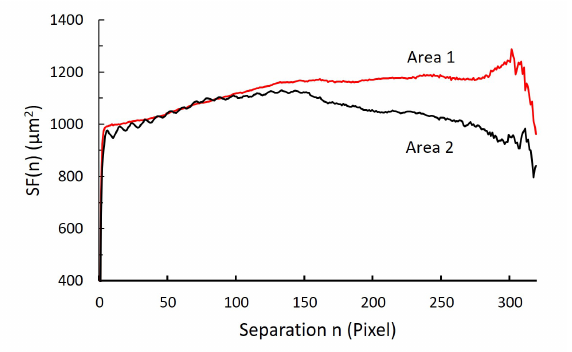
Figure 17. Multidirectional determined structure functions of area 1 (red) and area 2 (black). In the higher spatial frequency range up to about the separation n = 100, the amplitude of both SFs is almost identical. This clearly confirms the very similar roughness values. For further explanation, see text.